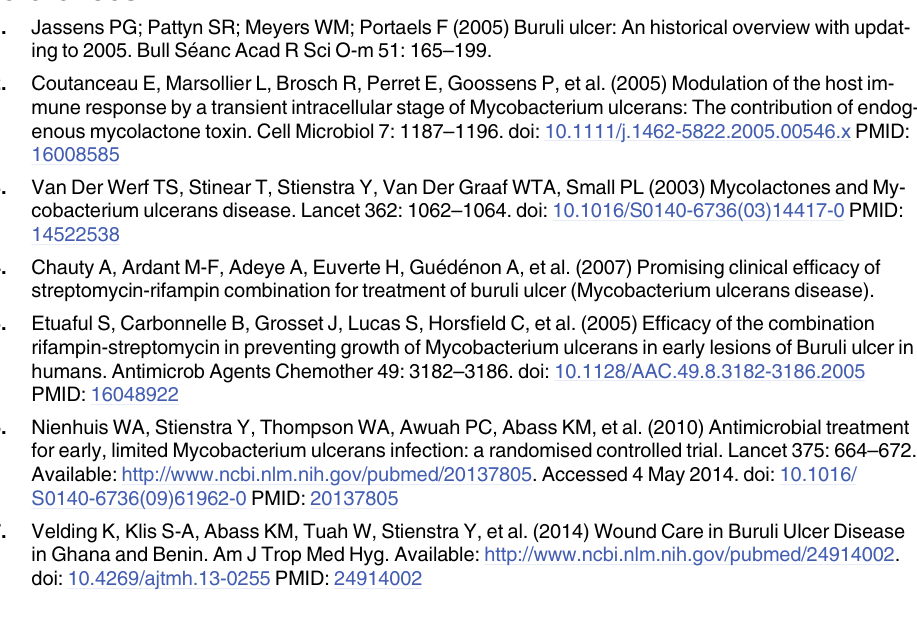
S1 Table. S. aureus isolates from BU patients listed in the order of the MLVF dendrogram. (XLSX) S1 Fig. Frequency of S. aureus isolation from different BU patients. The different colors rep- resent the types of samples from which S. aureus isolates were obtained: yellow — nasal swab, orange — wound swab, red — wound dressing. A white field indicates that the patient did not re- port to the healthcare centre, and a grey field that S. aureus was not detected. The successive time points at which samples were collected at the health centre are marked t1 to t13.